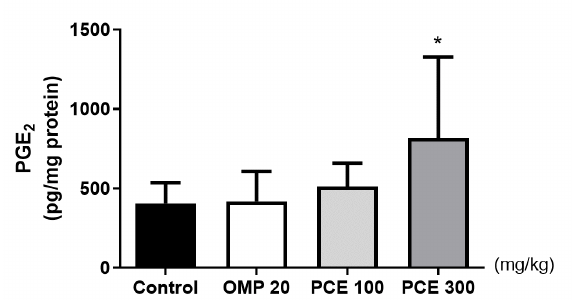
Figure 6. E ff ects of PCE on the levels of prostaglandin E 2 (PGE 2 ) in the stomach tissue of the hydrochloric acid / ethanol (HCl / EtOH)-treated rats. Rats were pre-treated orally with distilled water (control), OMP 20 mg / kg, PCE 100 mg / kg, or PCE 300 mg / kg 1 h prior to HCl / EtOH administration. Values are expressed as mean ± standard deviation. n = 7–8 per group. * p < 0.05 vs. control by Kruskal–Wallis test with Dunn’s multiple comparisons test. OMP, omeprazole; PCE, P. cuspidatum extract.